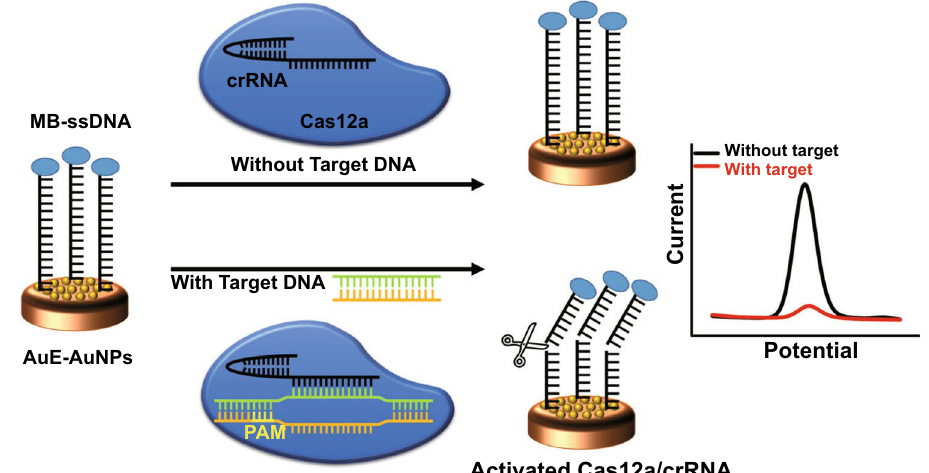
Fig. 1 Schematic representation of the AuNPs‑assisted E‑CRISPR